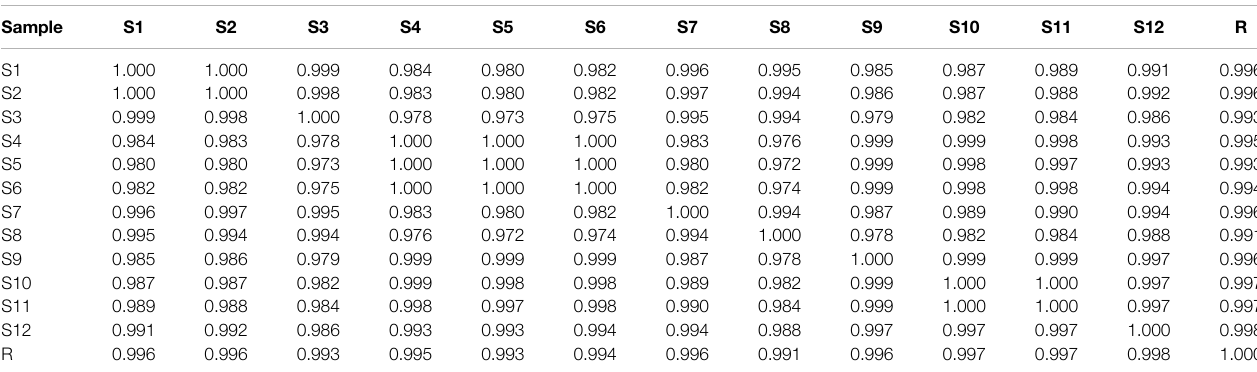
TABLE 4 | Chromatograms ’ similarity evaluation of standard decoction.